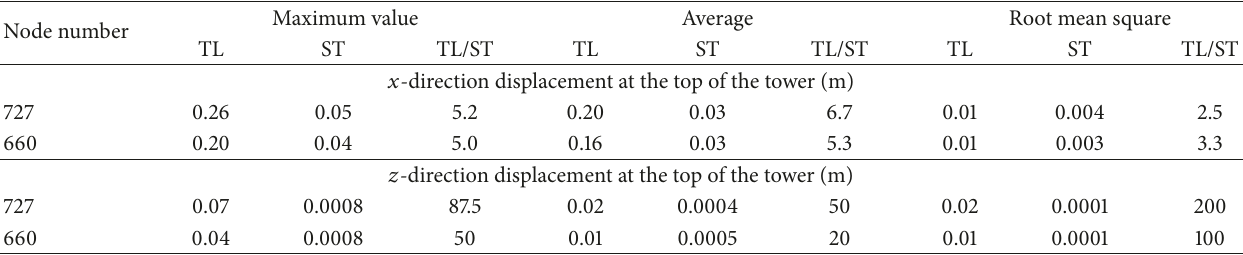
Table 8: Comparison of the dynamic analysis results of the displacement at the top of the transmission tower for the single tower and the tower-line system under a wind speed of 𝑈 10 = 25.3